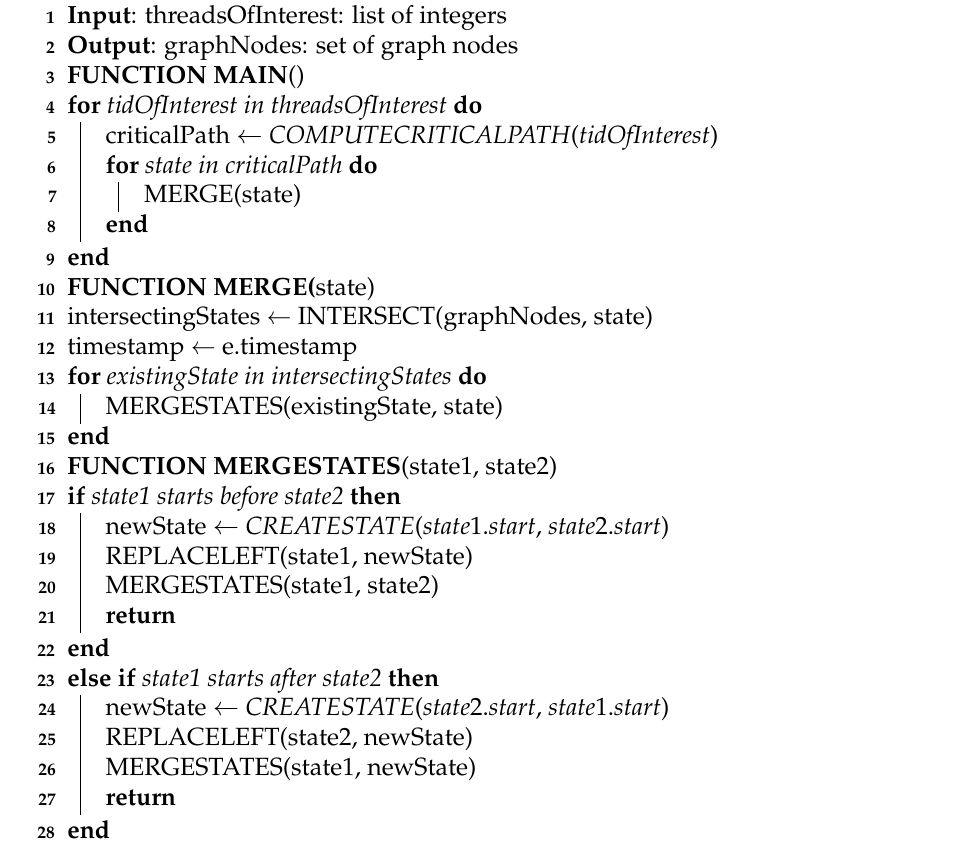
Algorithm 2: Pseudo-code version of the critical paths merging